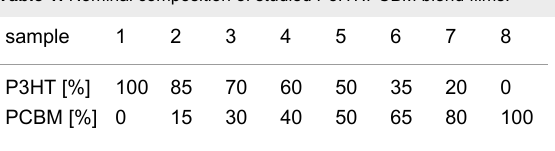
Table 1: Nominal composition of studied P3HT:PCBM blend films.